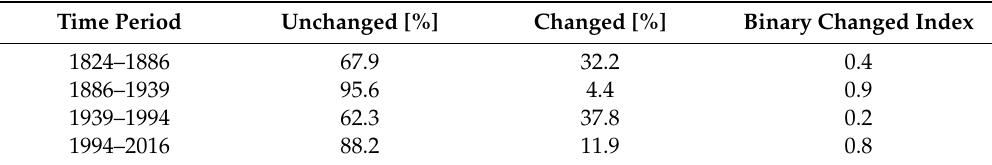
Table 6. Binary changed index of land